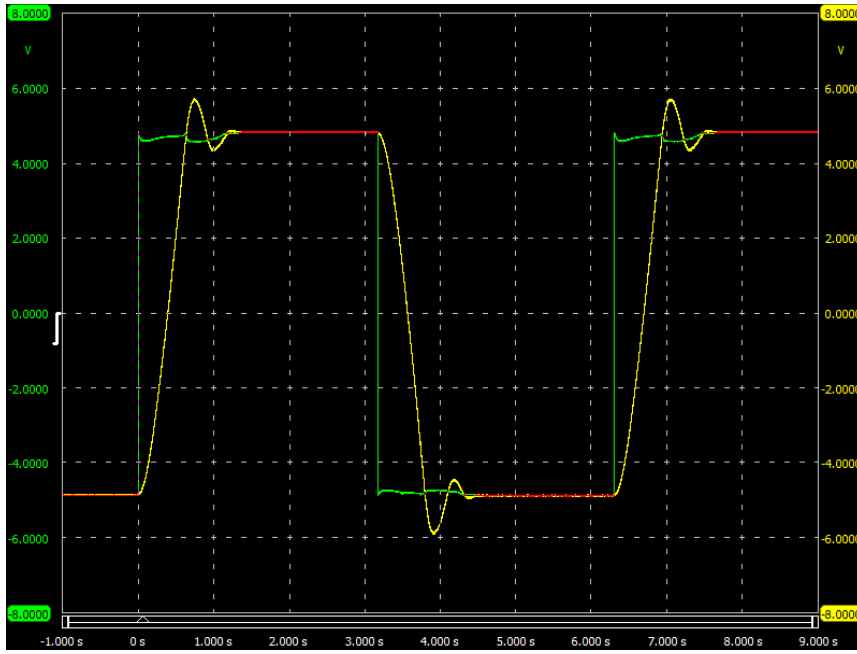
Fig. 4. Output response with ringing (op amp-based